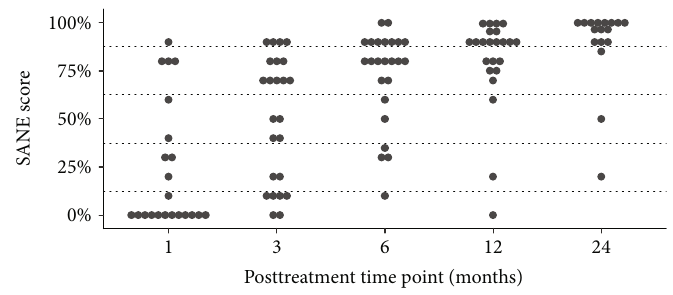
Figure 6: Modi fi ed SANE scores after BMC treatment at all time